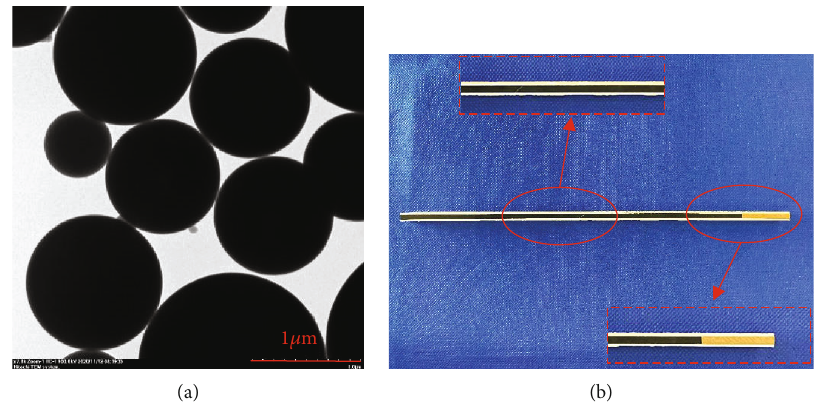
Figure 2: (a) TEM image of silica particles. (b) Image of sandwich structures.